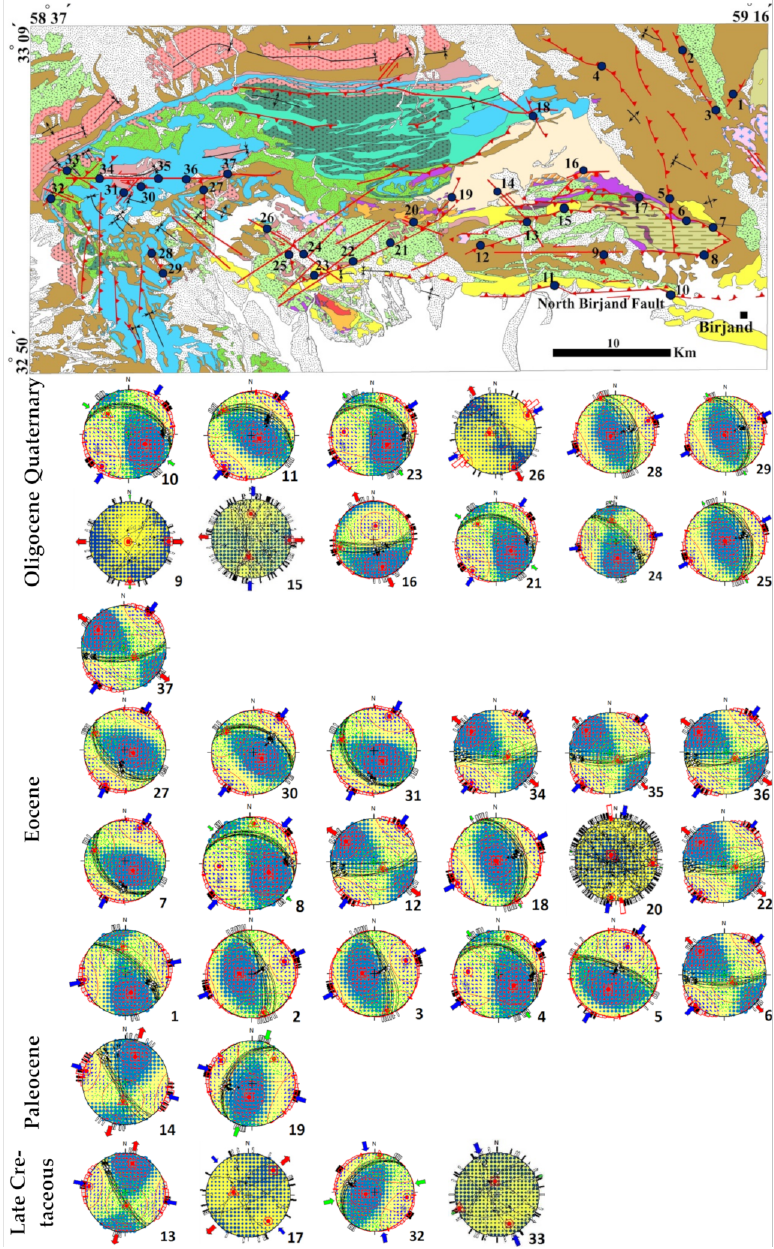
Figure 6. Orientation of the main stress axes related to the upper Cretaceous to Quaternary units. The numbers are the numbers of the sites that collected the faults